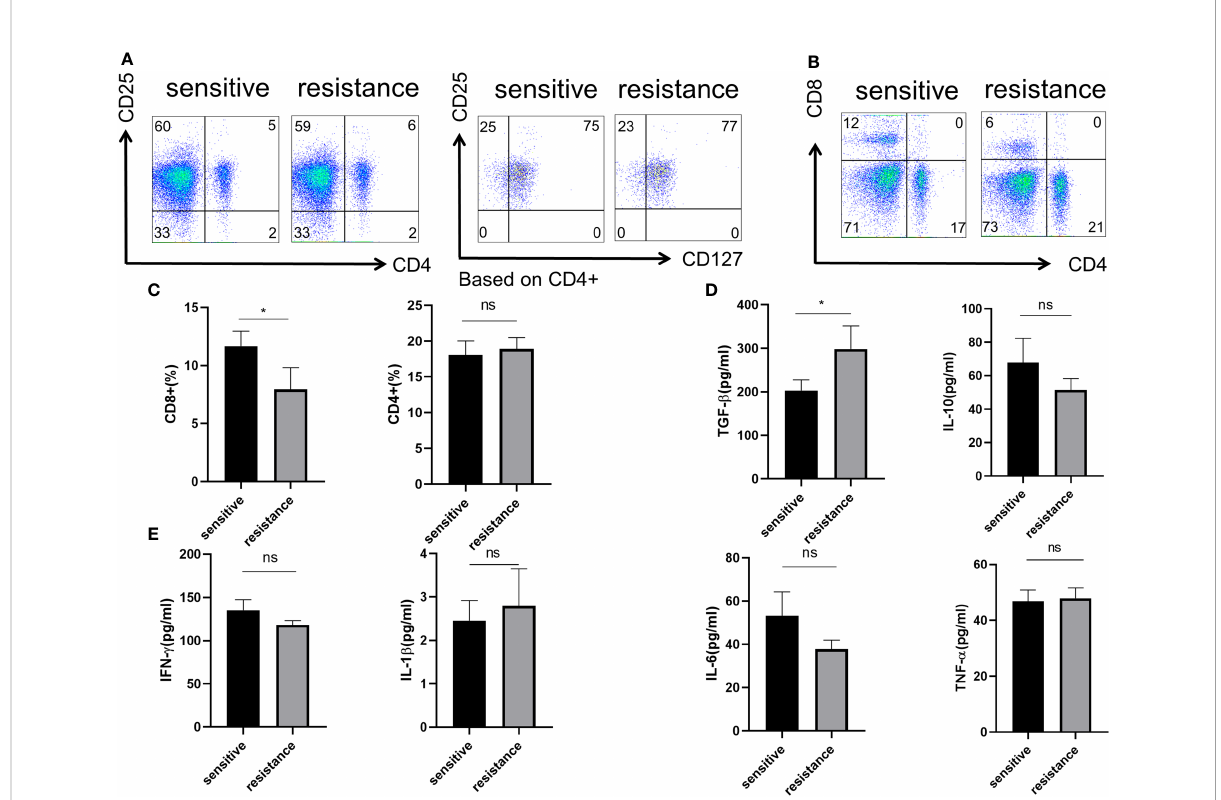
FIGURE 1 Role of Treg phenotype and cytokine expression in the peripheral blood of anti-PD-1-resistant patients. (A) Representative fl ow plot for CD4, CD25, and CD127 expression in the periphery blood of sensitive and resistant patients. (B) Representative fl ow plot for CD4 and CD8 expression in the periphery blood of sensitive and resistant patients. (C) The proportion of CD4+ and CD8+ T cells between both groups. The expression of anti-in fl ammatory cytokines (D) and in fl ammatory cytokines (E) from the serum was evaluated through ELISA. The bar shows the mean ± SEM of the levels of indicated proteins (sensitive patients n=4; resistant patients n=4). *p < 0.05. ns, non-signi fi